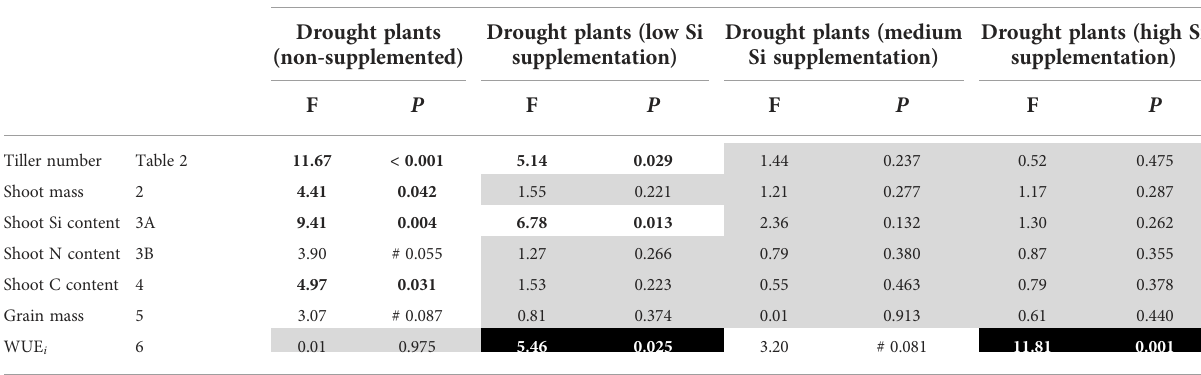
TABLE 3 Results of contrast analysis for plant traits showing a signi fi cant response to Si supplementation. Plant trait Figure/Table Ambient plants (non-supplemented) versus: Drought plants Drought plants (low Si Drought plants (medium Drought plants (high Si (non-supplemented) supplementation) Si supplementation) supplementation)